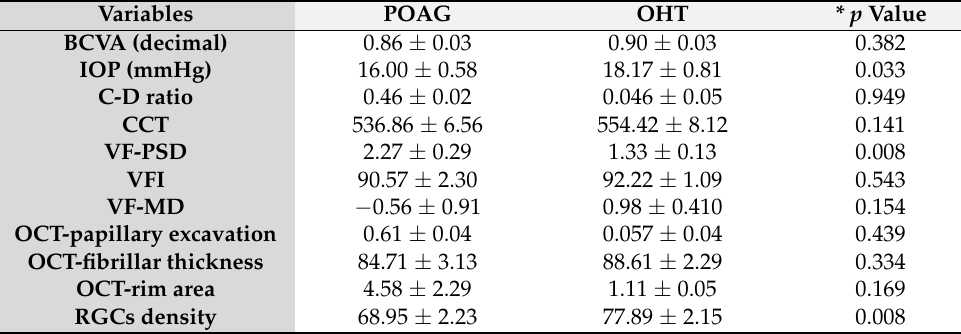
Table 3. Ophthalmological parameters of the study